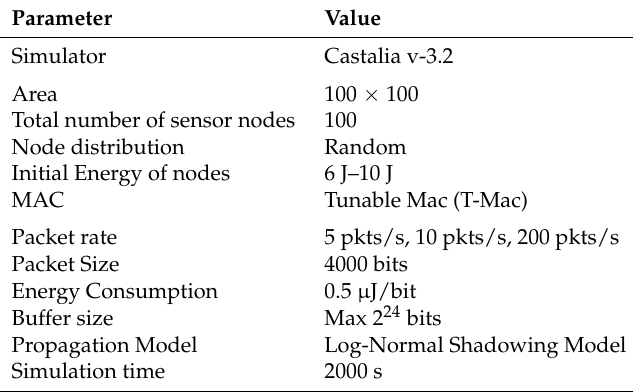
Table 1. Simulation Parameters.